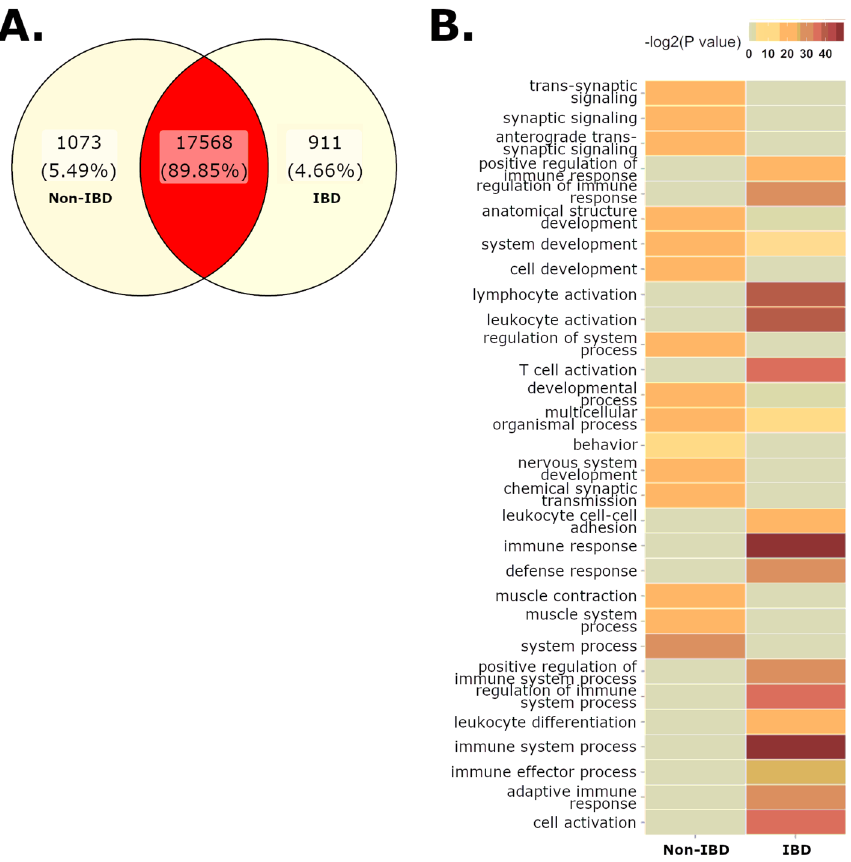
Figure 4. ( A ) Differentially expressed genes (DEG) (FDR < 0.05) in the jejunum of non-IBD and IBD cases. ( B ) IBD samples are enriched in GO sets associated with immunity and immune cell